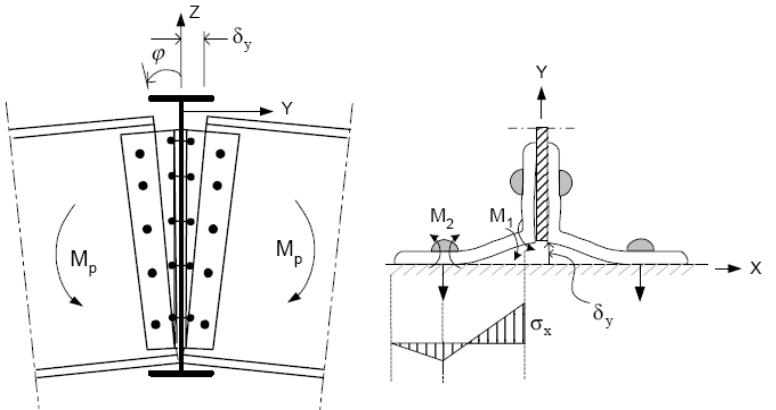
Figure 15. Secondary bending at stringer ends due to restrained end rotation. Bending and axial stresses at the top of the stringer-to-floor-beam connection might be high enough eventually to result in fatigue cracking.